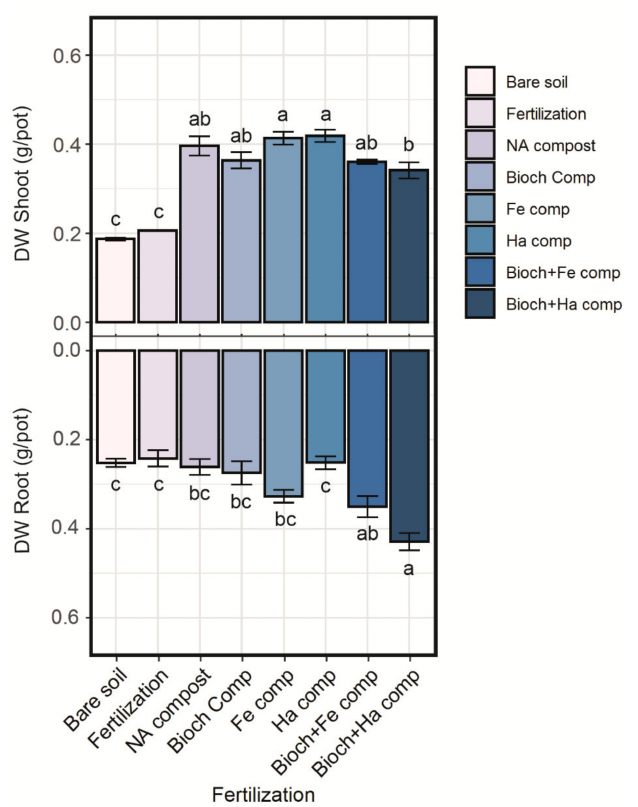
Figure 3. Effect of different compost and co-compost on plant biomass presented as dry weight (g) of root (DW Root) and shoots (DW shoot). Lower-case letters indicate significantly different means at p < 0.05.